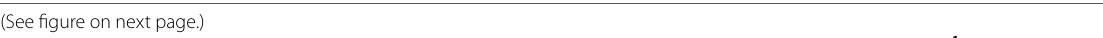
figure on next Fig. 4 Vertical distribution of multi-proxy parameters within investigated floodplains soils including plastic loads (p kg − 1 ), PLI, sand and clay content (%) as well as soil organic matter (SOM) content (%) grouped according floodplain positions (proximal, central, distal). a Sampling site NID (upper middle reaches) at river km 62; b Sampling site MOK (middle reaches) at river km 55; c Sampling site OKA (lower middle reaches) at river km 35; d Sampling site FRA (lower reaches) at river km